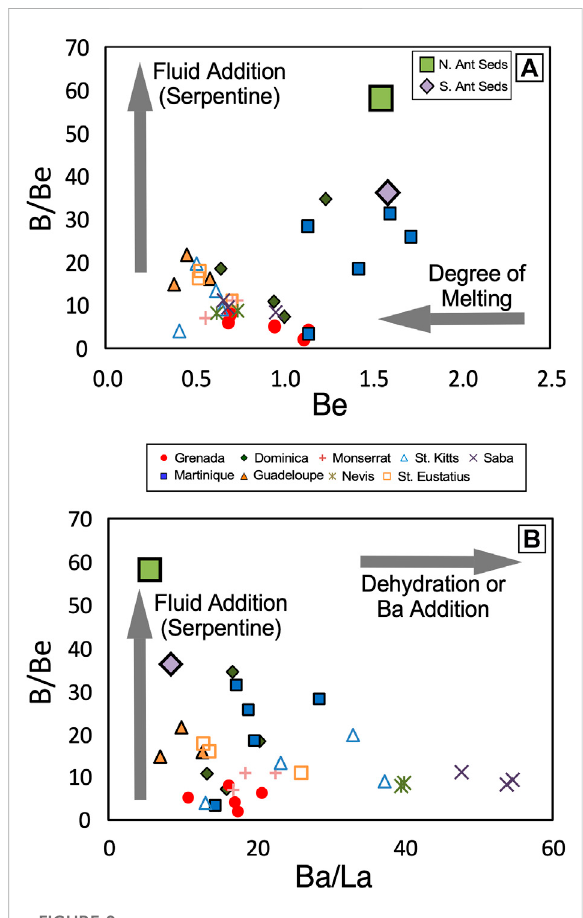
FIGURE 9 Plot of B/Be versus Be (A) and versus Ba/La ratios (B) . Higher B/Be is expected from increased slab fl uid addition (Hochstaedter et al., 1996), whereas serpentines have B/Be = 100 – 7,000